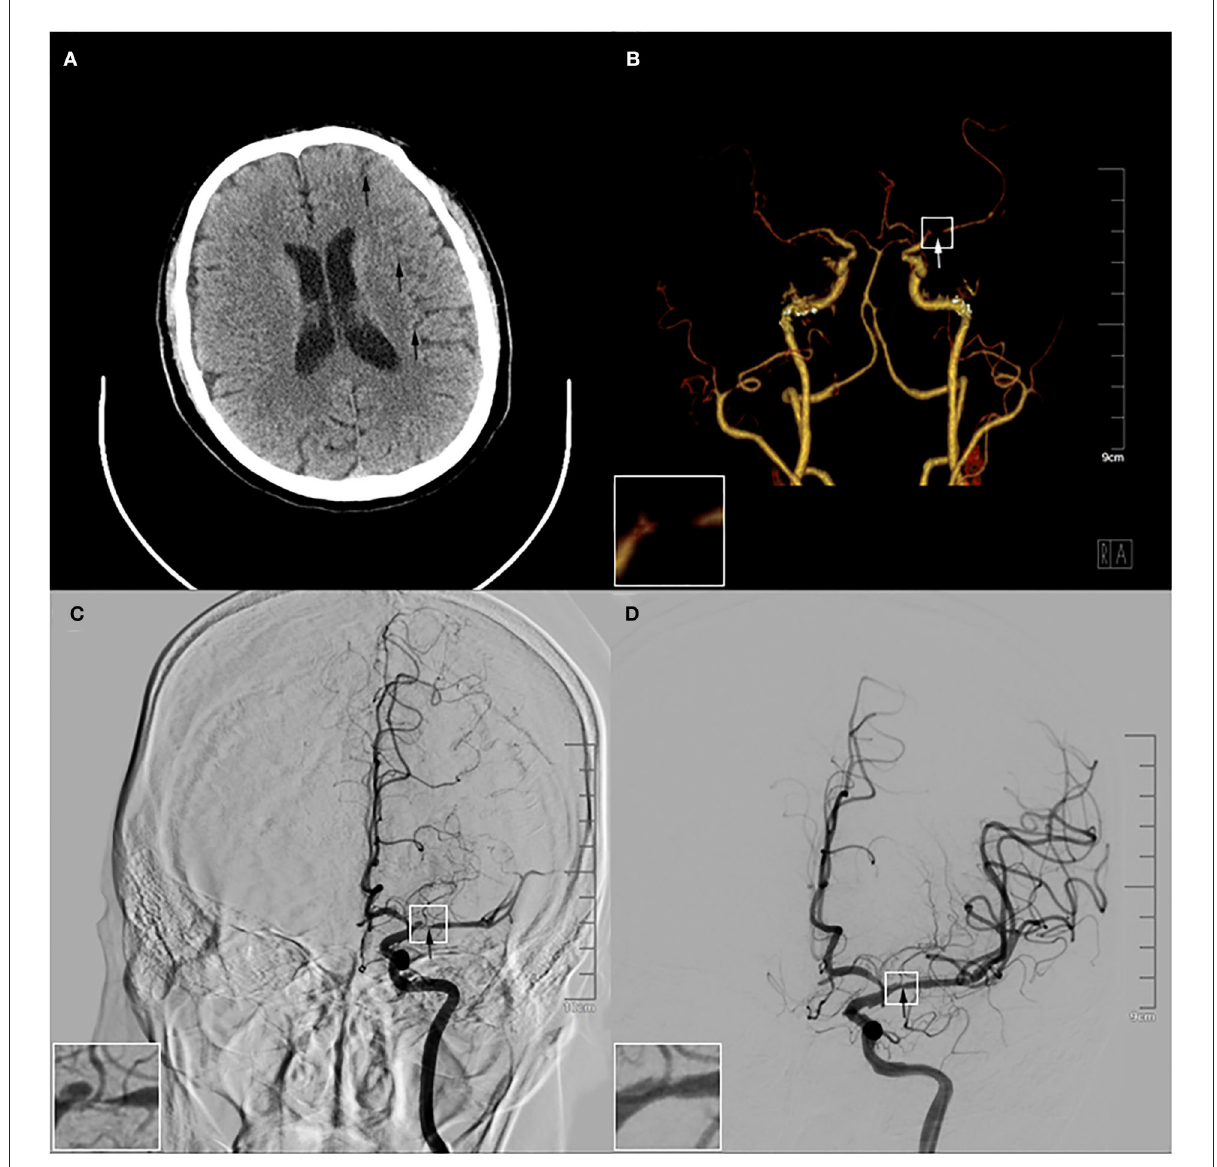
FIGURE2 Results of preoperative and intraoperative imaging examination. (A) The brain computed tomography showed multiple pieces of low-density signal were in the left cerebral hemisphere (arrows). (B) The computed tomography angiography exhibited the M1 segment of the left middle cerebral artery (LMCA) was partially interrupted (arrow). (C) The angiography before the operation displayed that there was stratification in the M1 segment of the LMCA (arrow). (D) The angiography after the operation demonstrated the stratification disappeared after the 3.5*20mm intracranial self-expanding stent had been released in the LMCA and the vascular morphology was significantly improved (arrow). The magnification of the white box were in the left lower corner of (B–D)